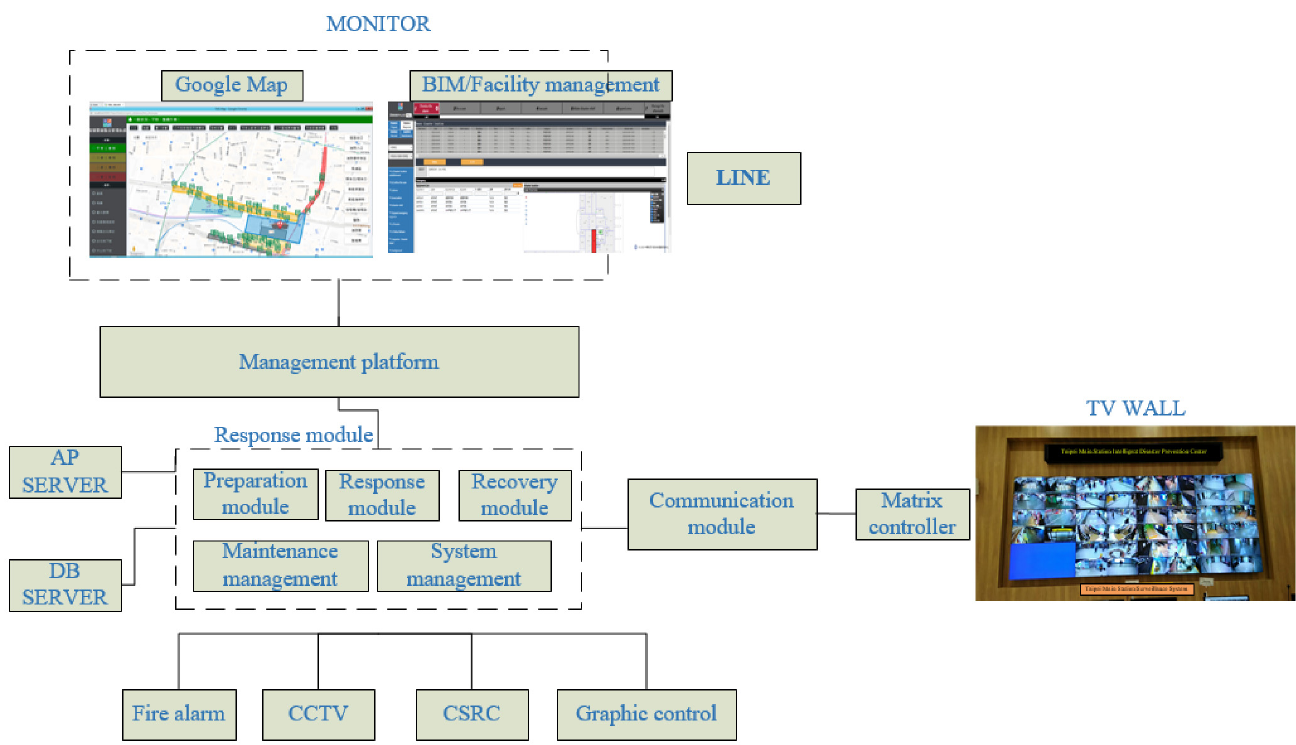
Figure 3. System interface diagram. (Source: Taipei Main Station Intelligent Joint Disaster Prevention Center, 2022).